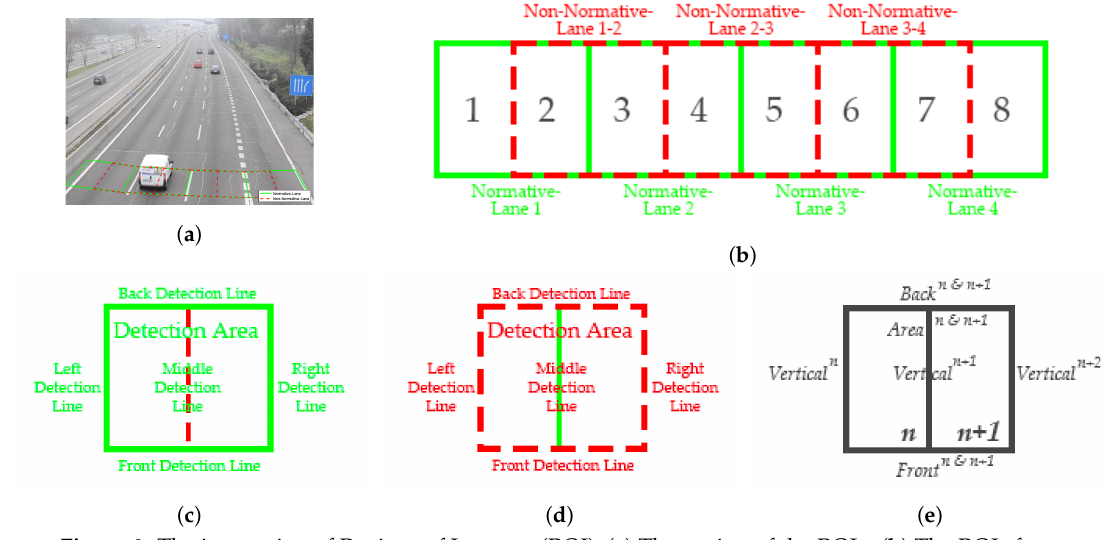
Figure 8. The instruction of Regions of Interests (ROI). ( a ) The setting of the ROIs. ( b ) The ROIs for a four-lane road. ( c ) The Normative-Lane ROI. ( d ) The Non-Normative-Lane ROI. ( e ) The normalized ROI. Table 4. The instruction of